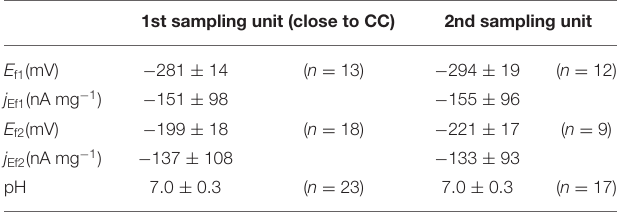
TABLE 2 | Overview about formal potentials ( E f ) and corresponding gravimetric current densities ( j ) obtained from granules sampled from the electrified biotrickling filters via sampling